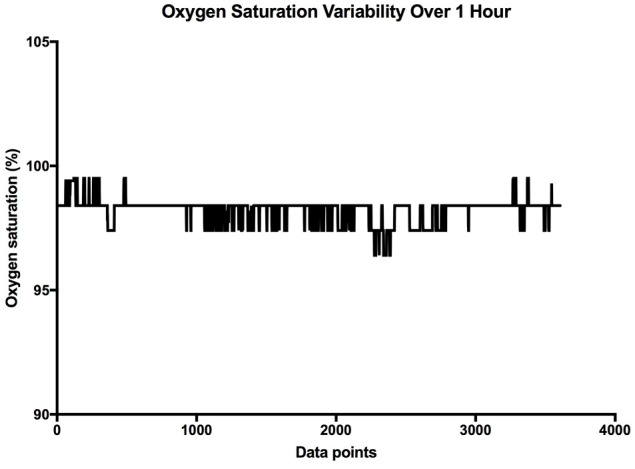
Sample SpO2 data collected over 1 h. The X axis is the cumulative data points, and the Y axis is the oxygen saturation.